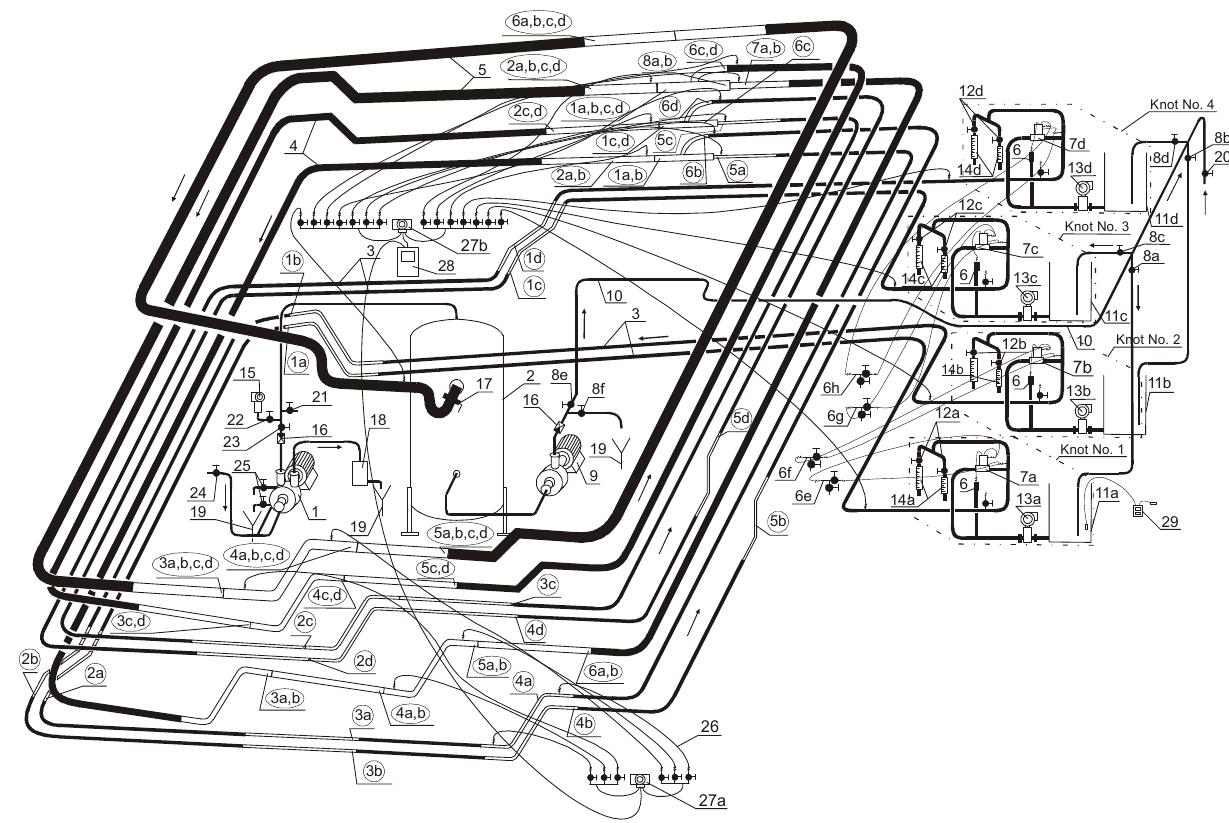
Figure 2. Scheme of the experimental installation of vacuum sewage system: 1-vacuum pump; 2-vacuum container; 3-vacuum pipeline with diameter of 57 mm; 4-vacuum pipeline with diameter of 81 mm; 5-vacuum pipeline with diameter of 102 mm; 6-sensor pipe; 6e,f,g,h-cutoff valve; 7a,b,c,d-interface valve; 8a,b,c,d,e,f-control valve; 9-water pump; 10-pressure pipeline; 11a,b,c,d-collector well; 12a,b,c,d-air control valve; 13a,b,c,d-electronic liquid flow meter; 14a,b,c,d-rotameter; 15-eelectronic meter of absolute pressure; 16-non-return valve; 17-throttling valve; 18-transparent container; 19-sewerage drain; 20-liquid supplying system cut-off valve; 21-vacuum container negative pressure control valve; 22, 23-vacuum pump air cut-off valve; 24-vacuum pump water cut-off valve; 25-vacuum pump working control valve; 26-impulse hose, 1a-6d-stand for observation of flow structures; 27a,b-electronic meter of pres-sure difference; 28-register of measurement results; 29-electronic